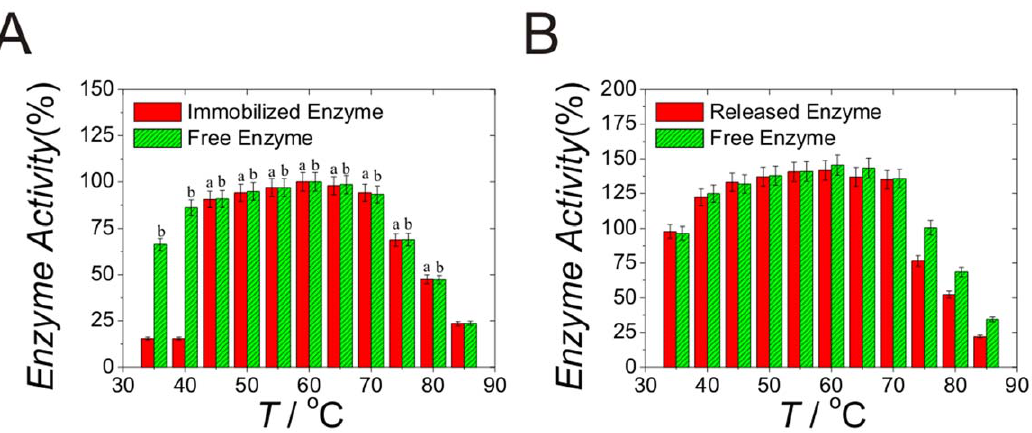
Figure 5. Activities of the glucoamylase at different temperature. (A) 30 mg of dialyzed and lyophilized powder was added into 3 mL of 1.0 mg/mL glucoamylase solution to perform the adsorption of enzyme at 60 u C for four hours and then at 25 u C for one hour. After centrifugation and washing process to remove free enzyme, the sedimentation of CLGNs were incubated at different temperature to determine the activities of released enzyme. The activities of free glucoamylase were also calculated at the same condition for comparison. (B) Comparison of enzyme activities for the released glucoamylase at 60 u C and free enzyme at temperature range of 30–85 u C a: Data are compared with the data of released enzyme at 40 u C and significantly different ( P , 0.05) from that data; b: Data are compared with the data of free enzyme at 85 u C and significantly different ( P , 0.05) from that data.